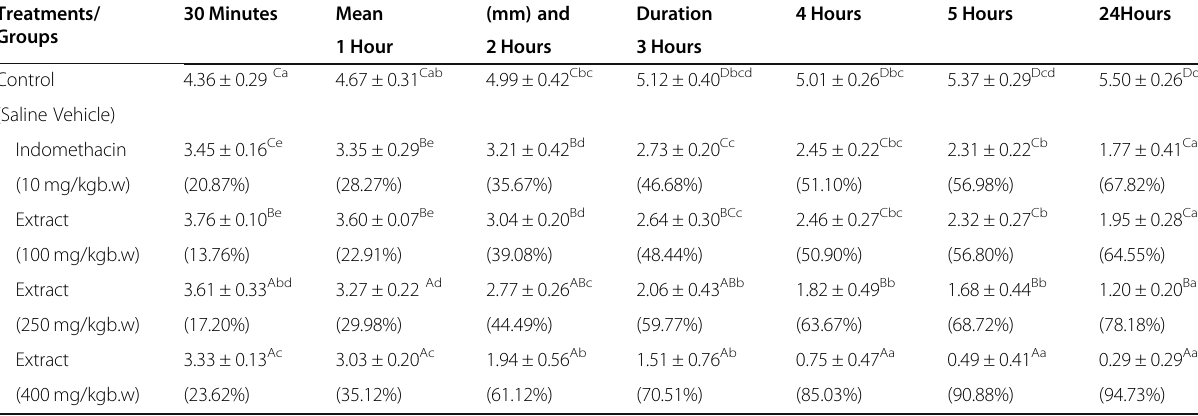
Table 3 Effect of Flavonoid-rich Extract Peltophorum Pterocarpum Stem Bark on Egg Albumin-Induced Rat Paw Oedema Treatments/ Groups